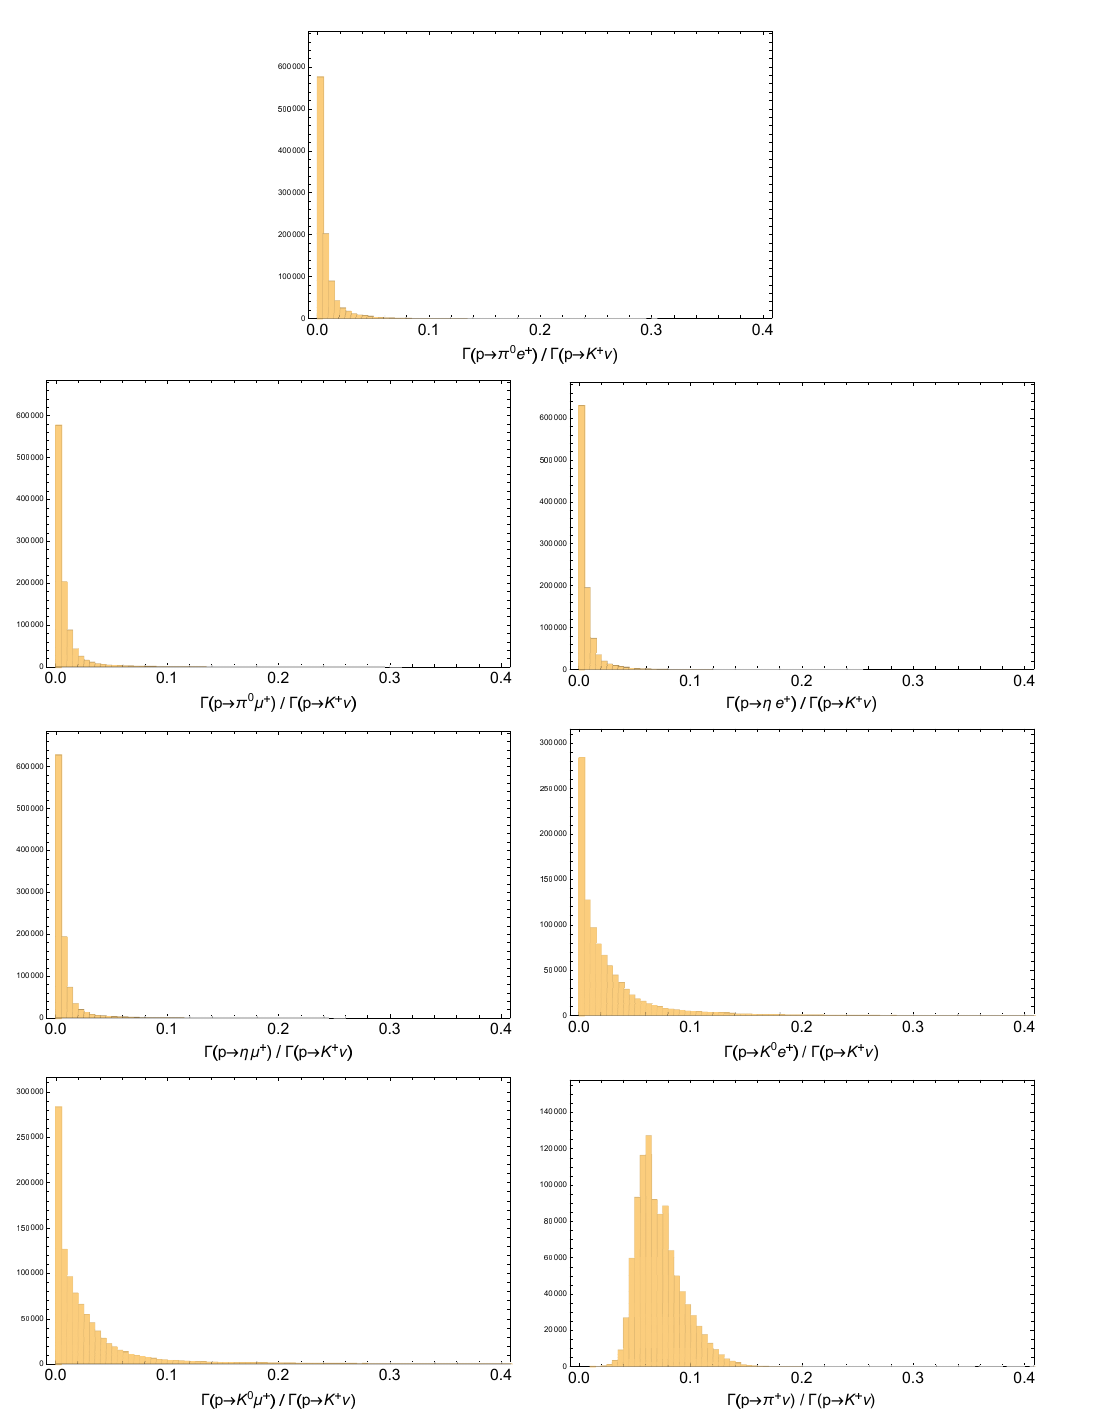
Figure 2 . Same as figure 1 except that we assume tan β = 50